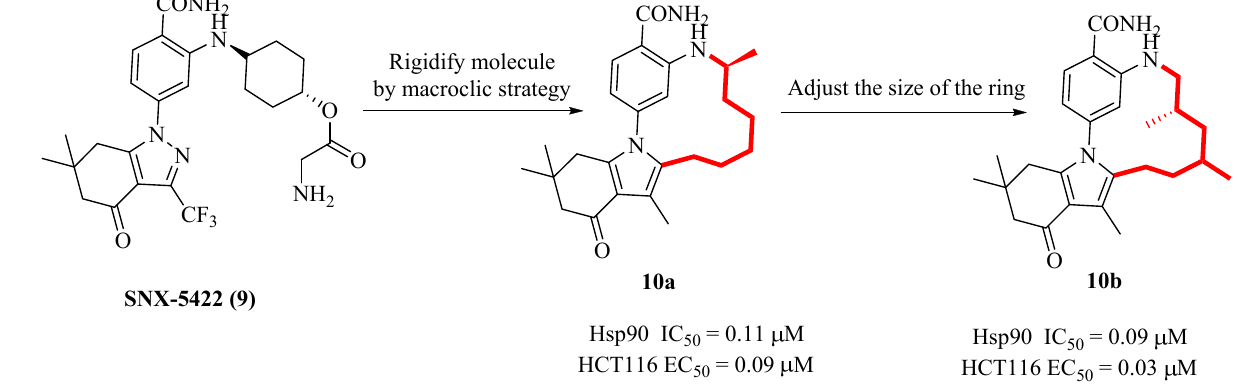
Figure 11. Structural modification of Hsp90 inhibitors.